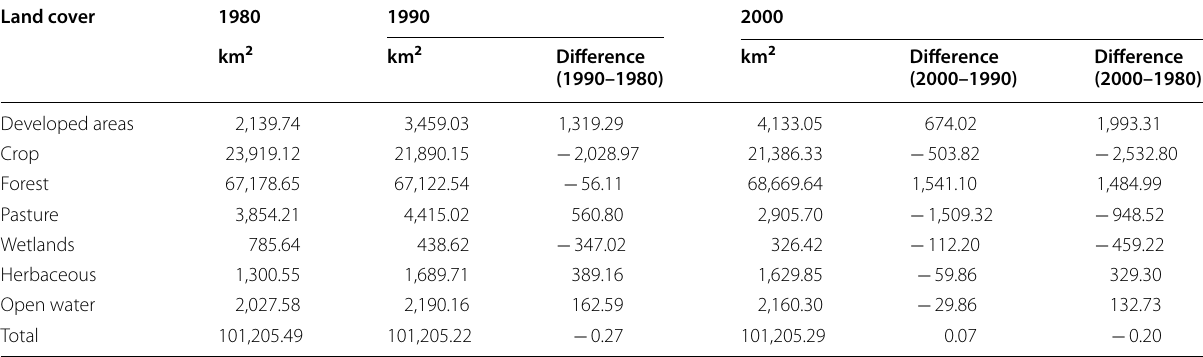
Table 3 Land cover change of South Korea in 1980, 1990, and 2000 Land